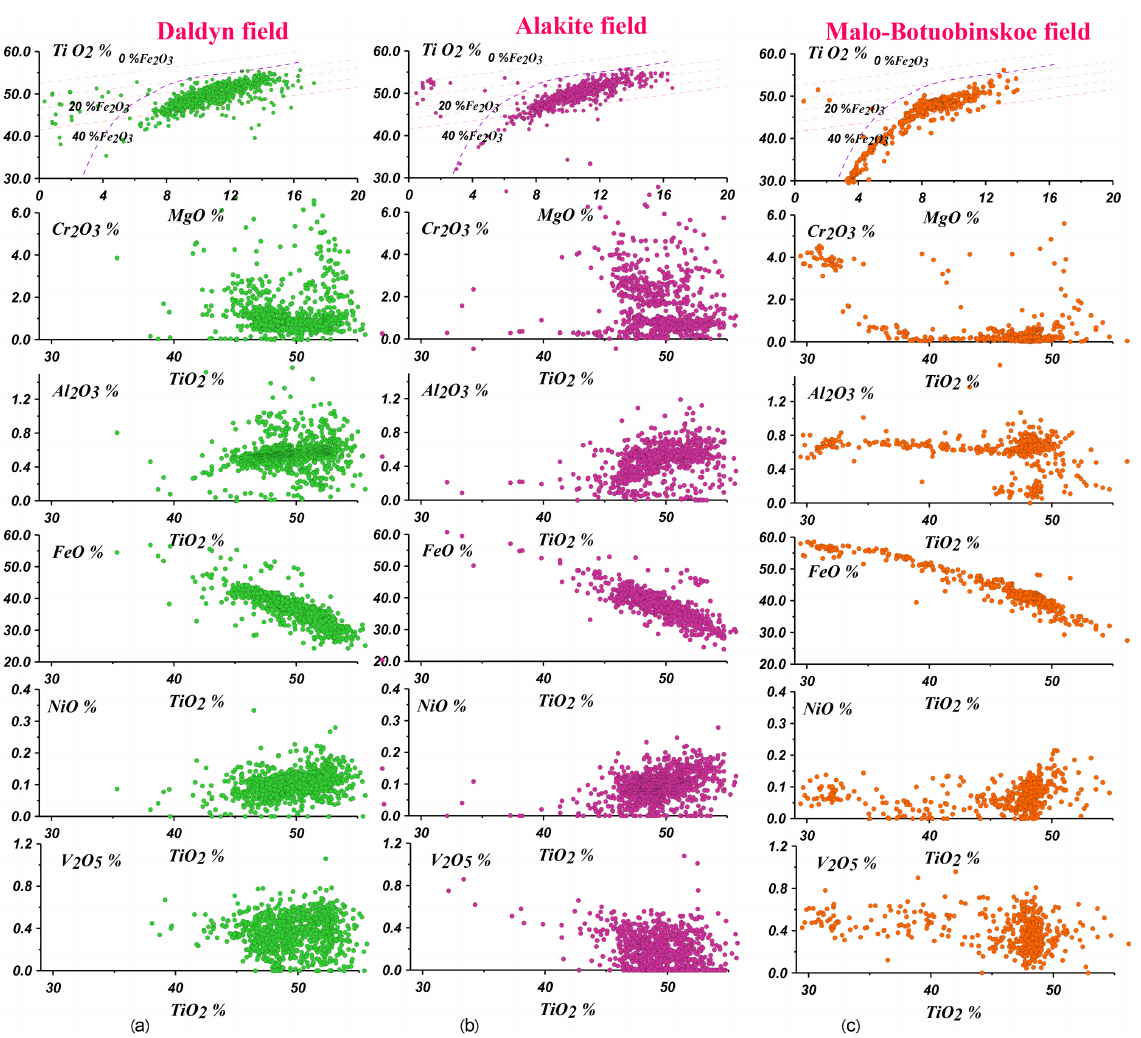
Figure 4. Variations of ilmenite compositions from different regions Yakutian kimberlite province (Daldyn, Alakit and Malo-Botuobinsky